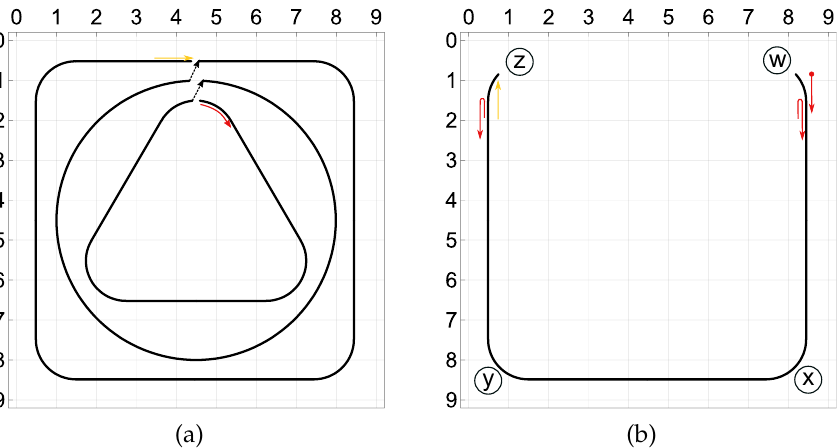
Figure 12. Two compound trajectories constructed using the three basic experimental trajectories: ( a ) The load follows each of the basic trajectories once. ( b ) The load follows three times the U-shaped path along the points